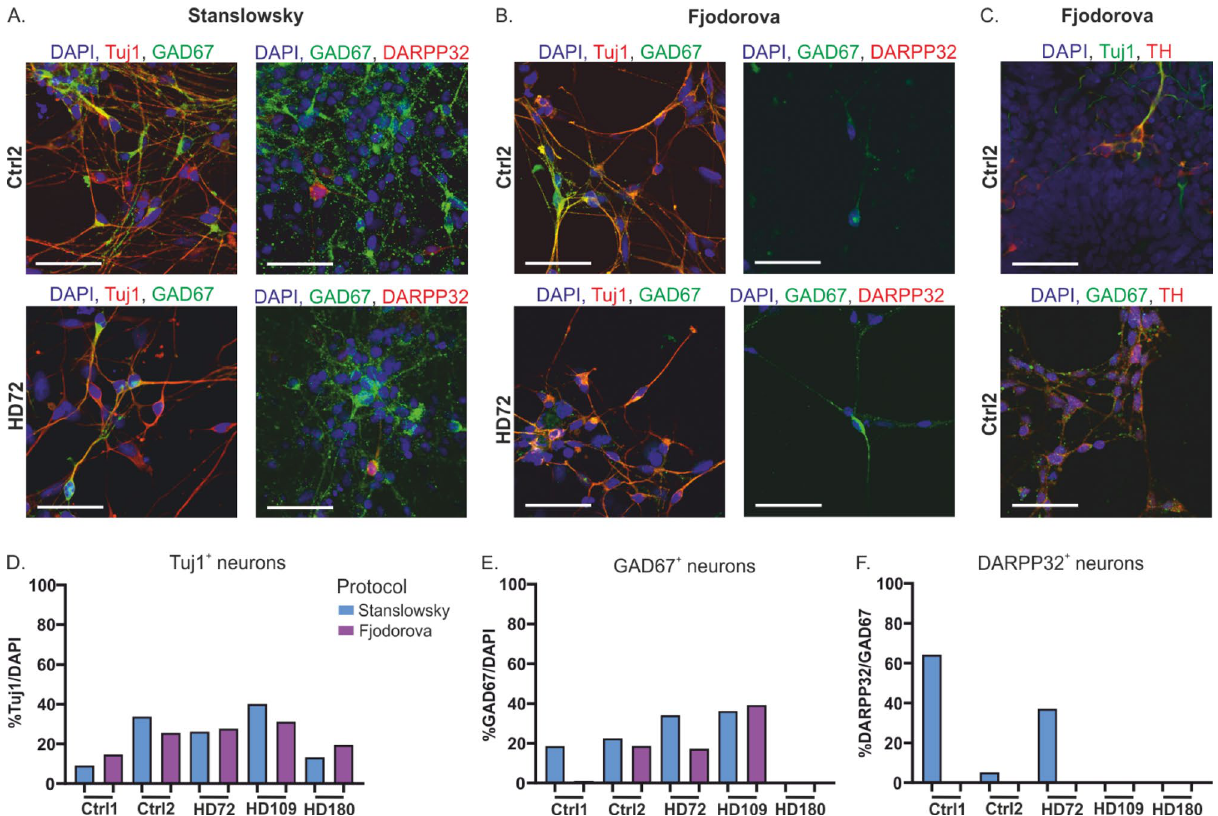
Figure 4. Both differentiation protocols produce only a small percentage of MSNs. ( A , B ) Representative immunostaining of Ctrl2 (bottom) and HD72 neurons (top) from the Stanslowsky protocol ( A ) and the Fjodorova protocol ( B ). DAPI staining is represented in blue, Tuj1 and DARPP32 in red and GAD67 in green. Scale: 50 µm. ( C ) Ctrl2 neurons of the Fjodorova protocol stained with Tuj1 in green and TH in red (top) or with GAD67 in green and TH in red (bottom). ( D ) Percentage of Tuj1 + neurons in each culture compared to the number of DAPI-stained nuclei. ( E ) Percentage of GAD67 + neurons (GABAergic neurons) in each culture compared to the total number of DAPI-stained nuclei. ( F ) Percentage of DARPP32 + neurons (striatal MSNs) in each culture compared to the number of GAD67 + neurons. See Supplementary Table S6 for quantitative data. Data show mean (1 technical